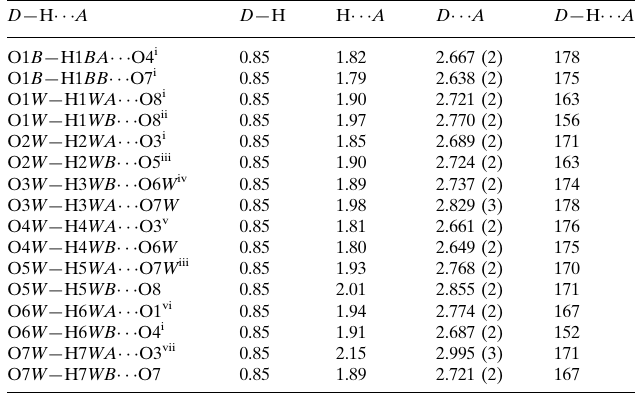
Hydrogen-bond geometry (A˚ , (cid:3)